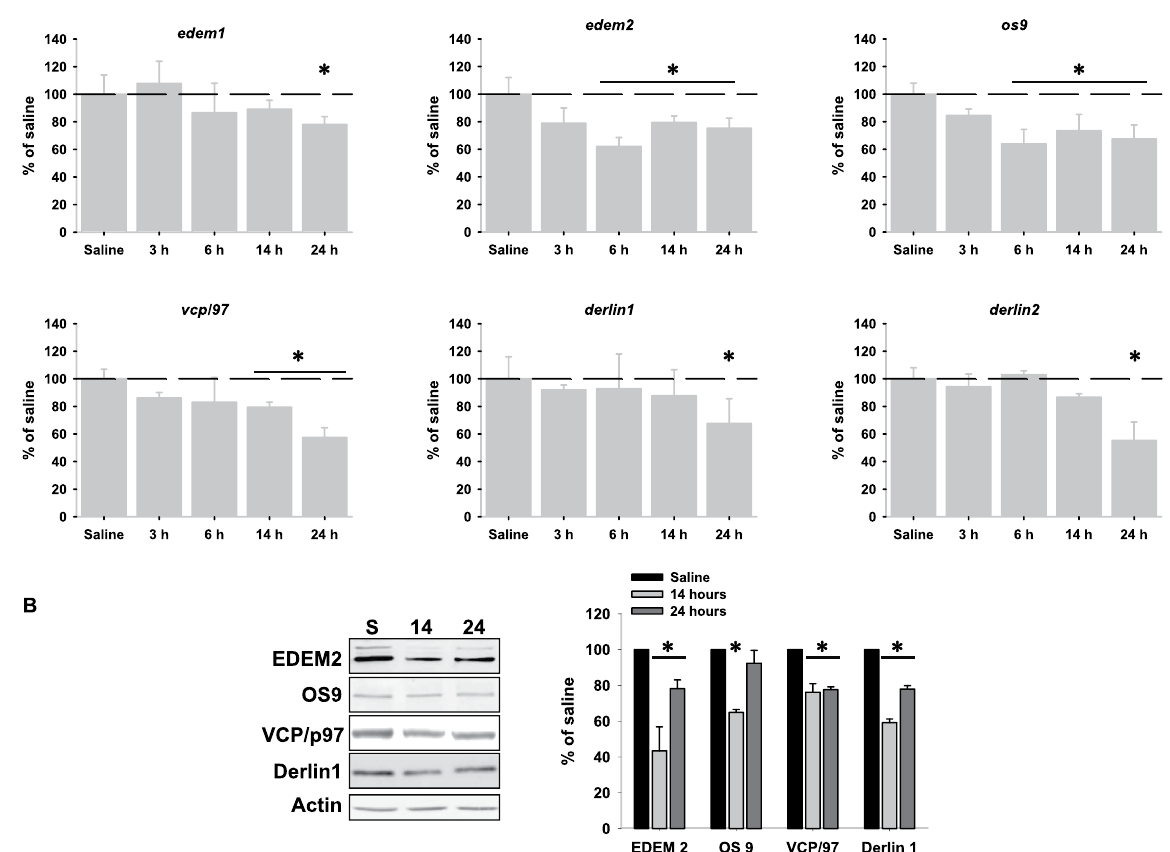
Figure 6. LPS injection down-regulated ERAD markers expression. ( A ) mRNA expression of ERAD markers involved in both recognition (upper panel) and retro-translocation (lower panel) of unfolded and/or malfolded ER proteins analyzed by RT-real time PCR after LPS-injection. Note the significant reduction in the expression of all of the markers analyzed at 24 hours. ( B ) Representative western blot corresponding to selected ERAD proteins of the same animals at 14 and 24 hours after LPS-injection. Data are presented as mean ± SD (n = 4) of percentage of variation relative to controls. * p < 0.05, significant differences compared with control (saline- injected)